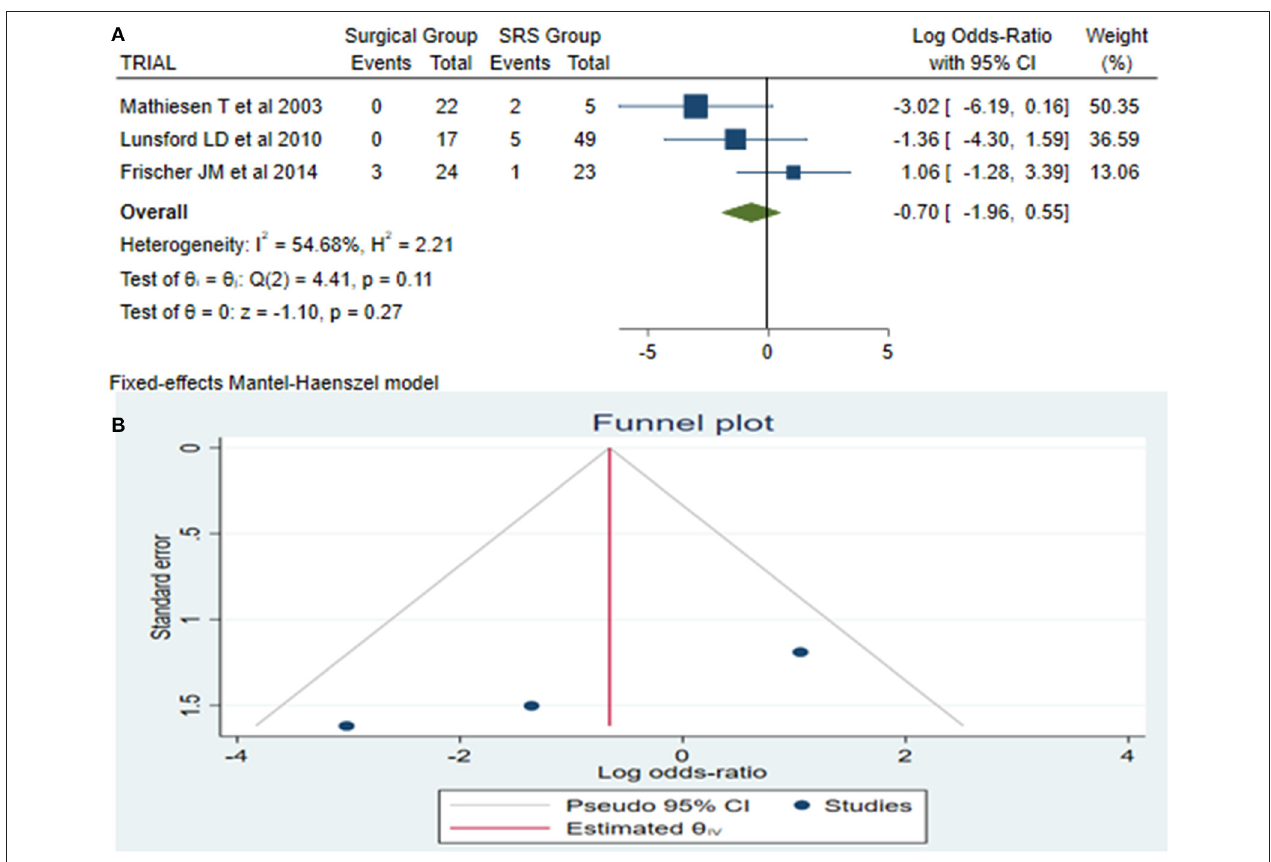
FIGURE 4 | Late rebleeding (LaReBl): (A) OR forest plot LaReBl: Results demonstrate no statistically significant difference between the two groups [decimal logarithm of odd ratio—(log OR − 0.70, CI 95% − 1.96–0.55, and p = 0.27), with heterogeneity ( p = 0.11 and I 2 = 54.68%)], and (B) funnel plots of the LaReBl demonstrated no publication bias. SRS, Radiosurgical group; I 2 shows the percentage of total variation across studies that is due to heterogeneity rather than chance; CI, confidence